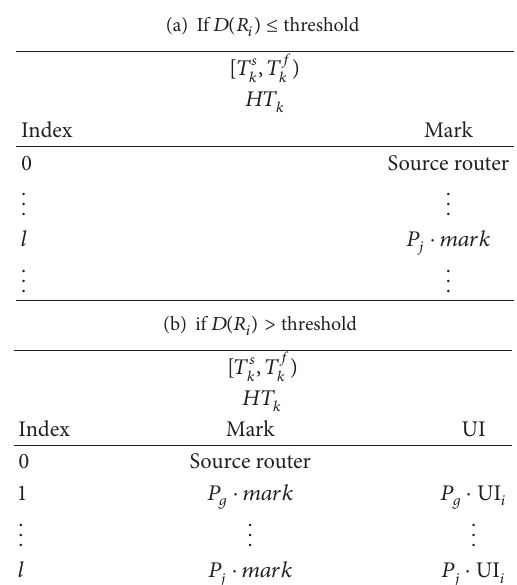
Table 2: Example of any log table 𝐻𝑇 𝑘 .